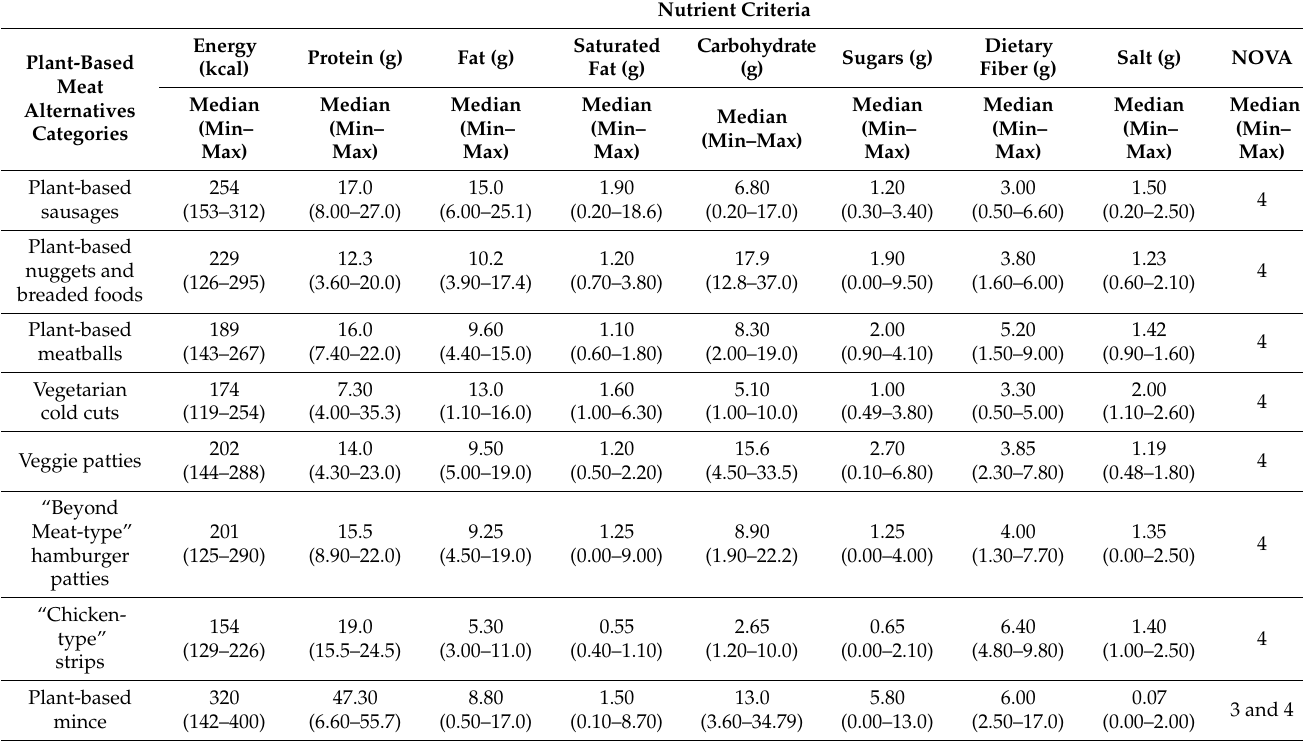
Table 6. Nutrients/100 g (median, minimum–maximum) and NOVA